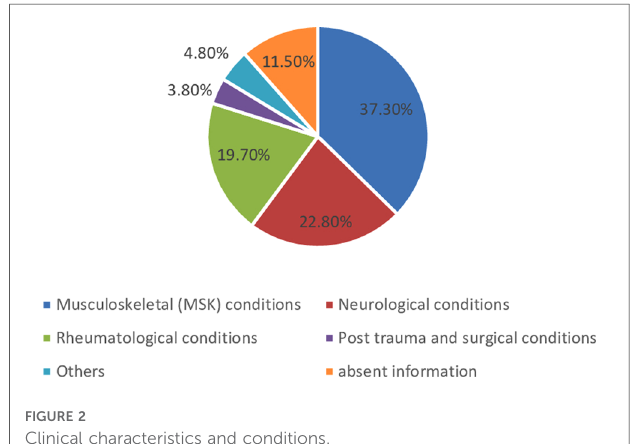
FIGURE 2 Clinical characteristics and